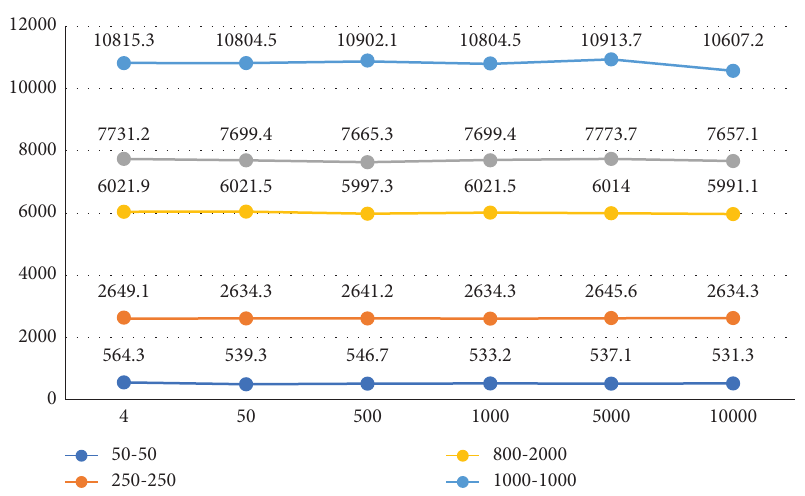
Figure 13: Alpha ( α )